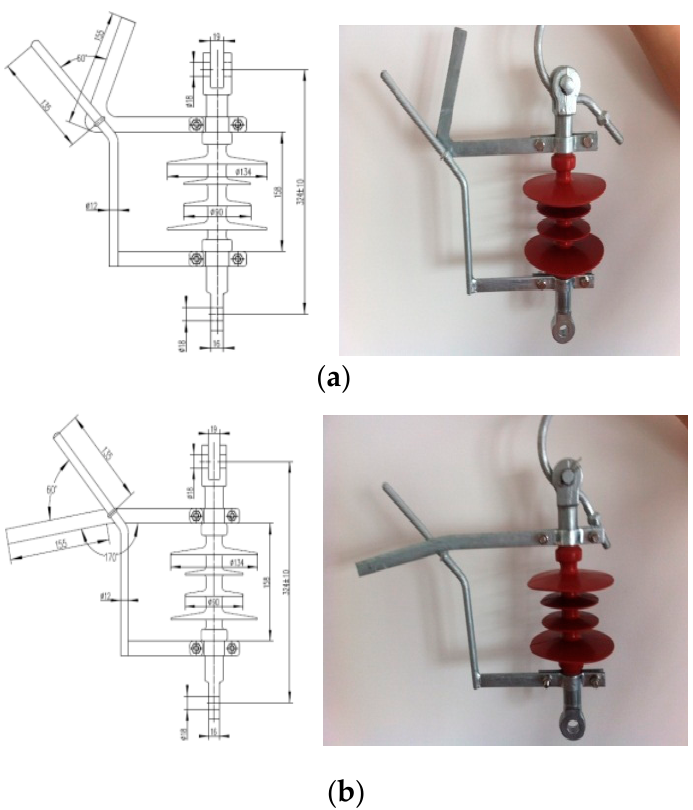
Figure 2. Structure diagrams of the ground wire insulator and parallel discharge gap: ( a ) the pendants; ( b ) the tensioning. Table 1. Technical parameters of the ground wire insulator. Parameters Value